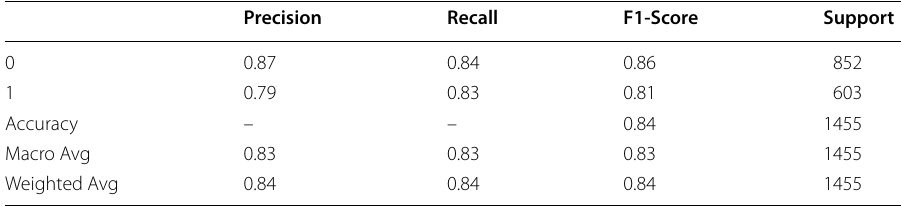
Table 10 Experiment 2 with SemEval dataset